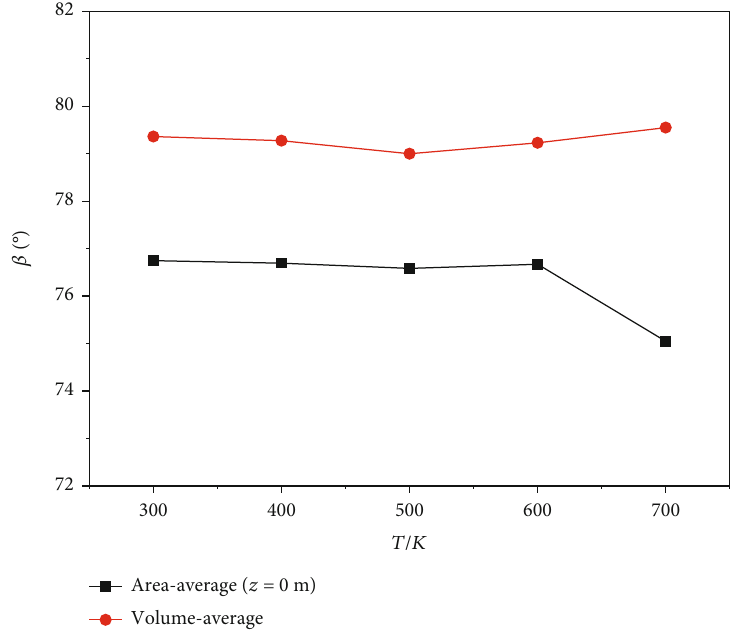
Figure 32: Volume average synergy angle and area average synergy angle under di ff erent inlet